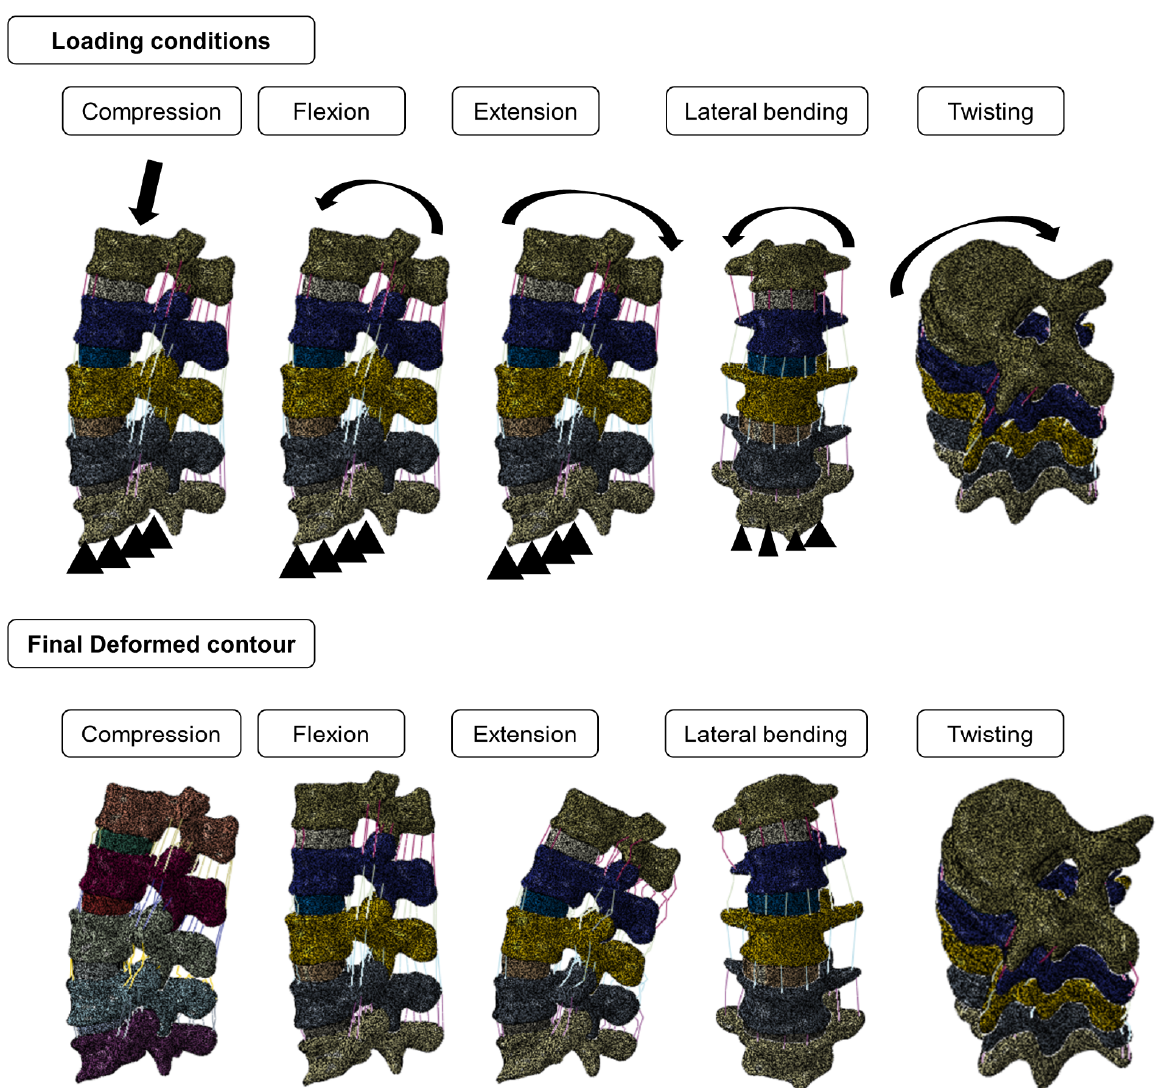
Figure 4. Applied loading and final deformed contours of the lumbar spine models. The top row shows the different loading conditions, i.e., compression, flexion, extension, lateral bending, and twisting. The bottom row shows the final deformation contours for the abovementioned loading conditions.